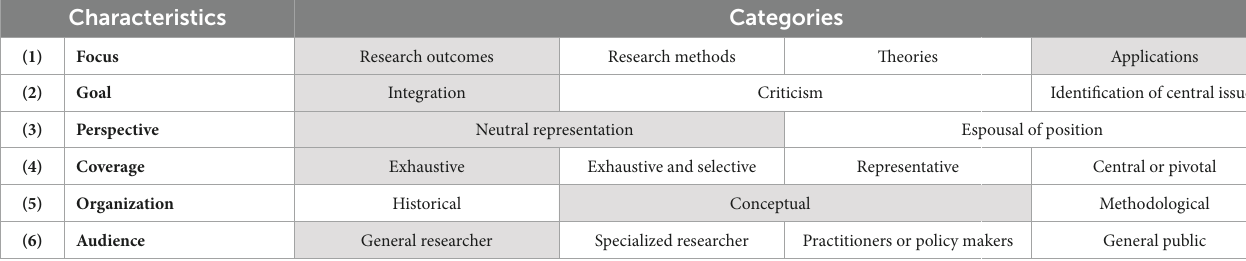
TABLE 2 Taxonomy of literature reviews (adapted from Cooper, 1988, p: 109).